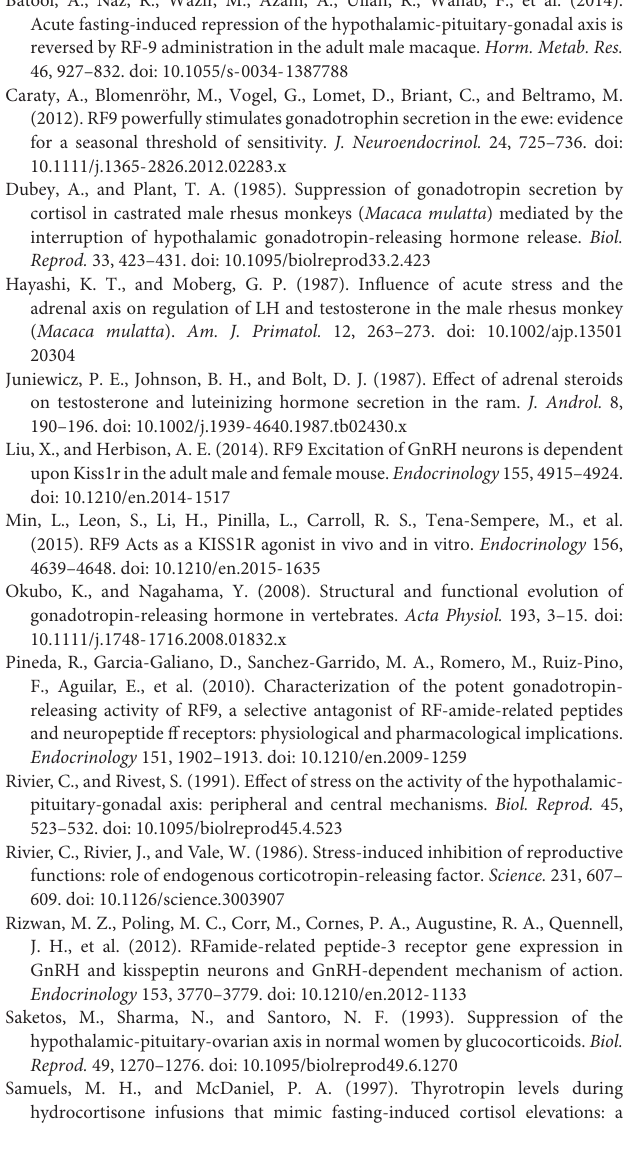
Supplementary Table 1 | Raw data of assays (Elisa) with the calculation of %